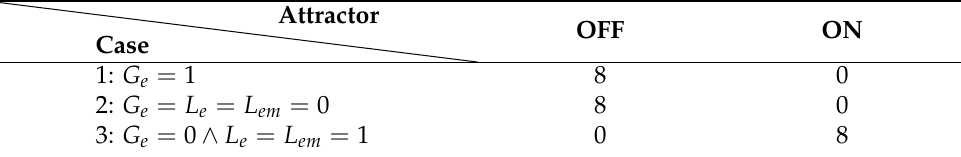
Table 4. Size of the attraction basin associated with the dynamics of cases 1, 2 and 3 for the reduced model (Section 3.2) and considering any of the | S 3 | = 13 possible updates schedules.